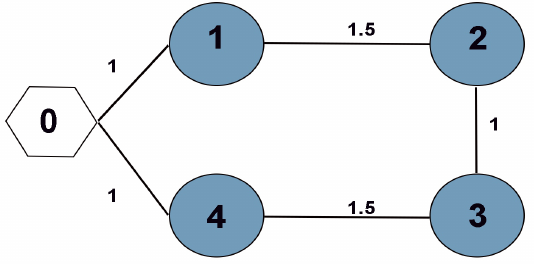
Figure 7. Interaction topology between